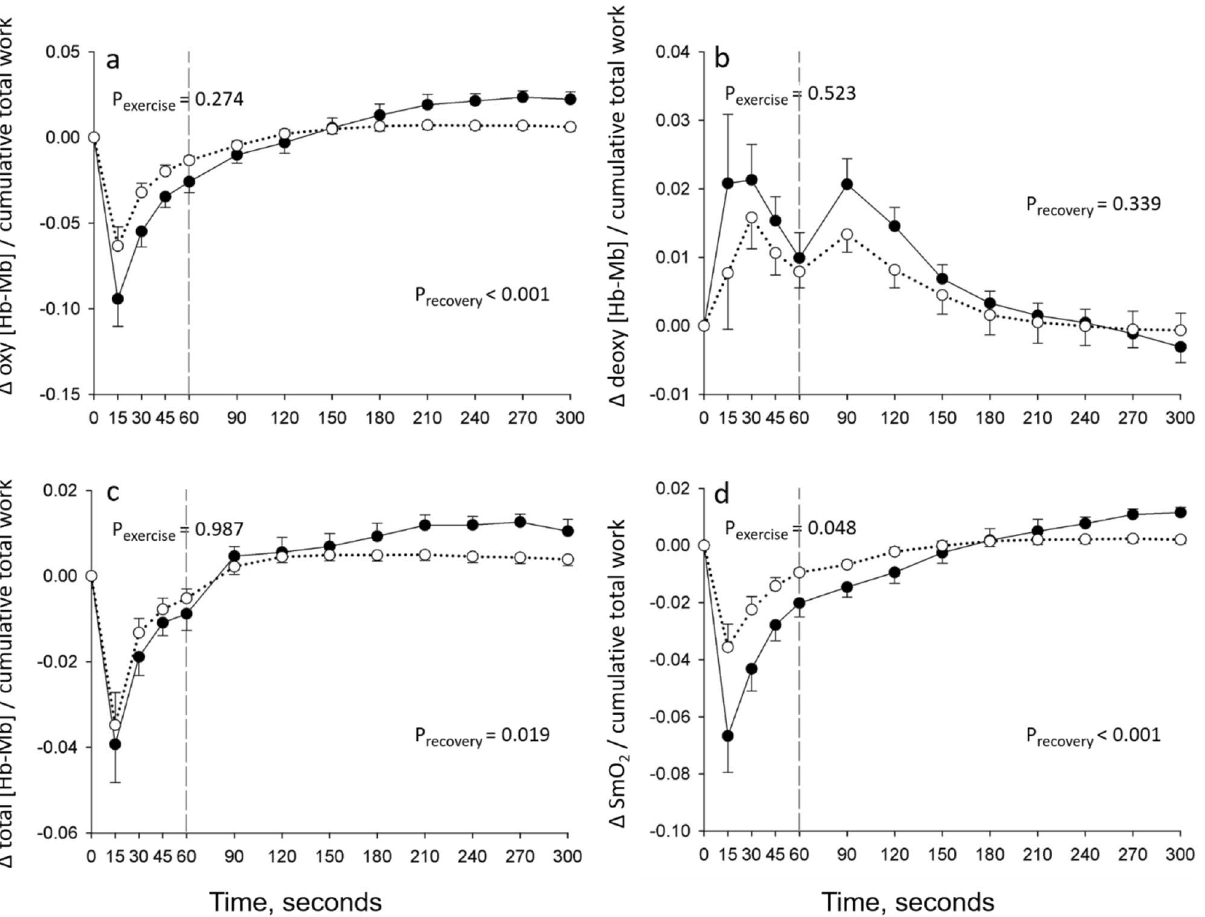
Figure 3. Time course of quadriceps ( a ) oxygenated (Δ oxy [Hb-Mb]), ( b ) deoxygenated (Δ deoxy [Hb-Mb]), ( c ) total (Δ total [Hb-Mb]) myoglobin–hemoglobin concentration, and ( d ) muscle saturation index (Δ SmO 2 ) per unit of cumulative total work during the 1STS and 4 min of recovery in people with COPD (full circles) and healthy subjects (open circles). Results are presented as mean ± SEM. Exercise and recovery data were analysed with two distinct two-way repeated measure ANOVAs, the p values report the interaction group x time during the 1STS and during the recovery periods, separately.